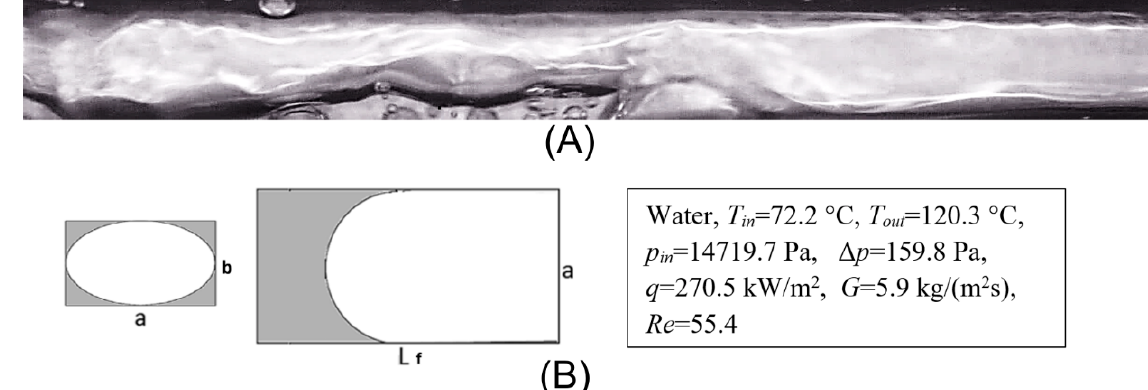
Figure 9. ( A ) Case III—top view video frame; ( B ) predicted, approximate shape of elongated, partially visible vapor bubble in cross section (left) and top view (right) of the mini-channel.